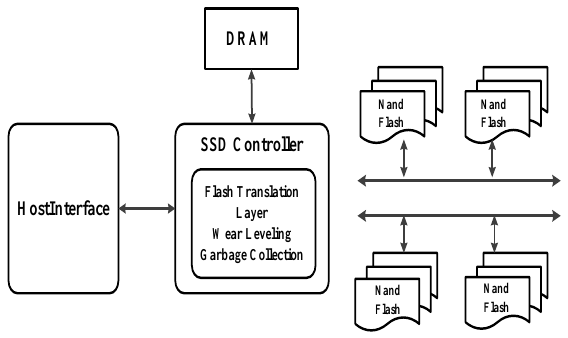
Fig. 1. The block diagram of a traditional SSD